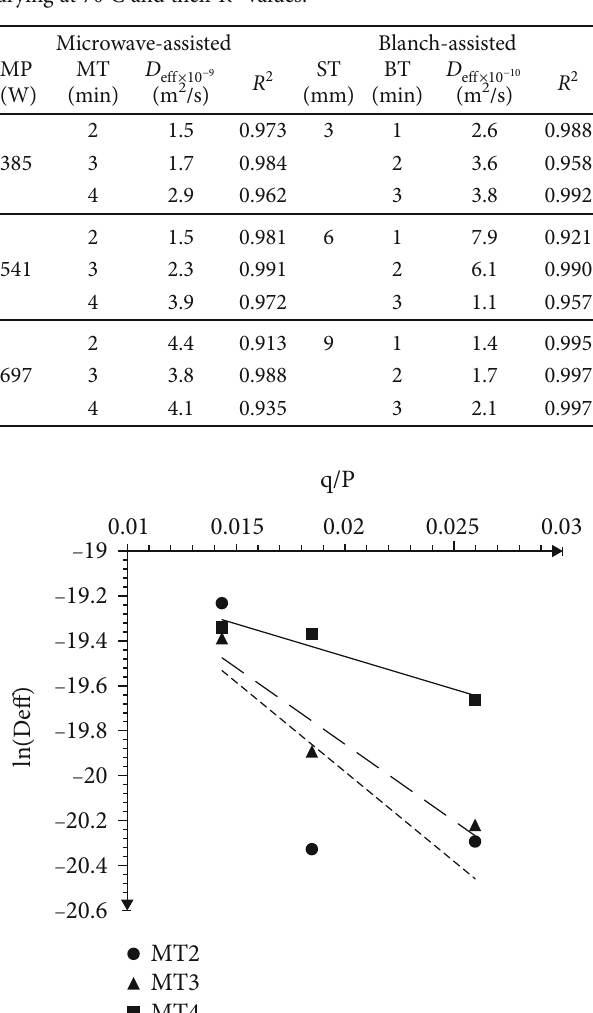
Figure 3: Variation of In D